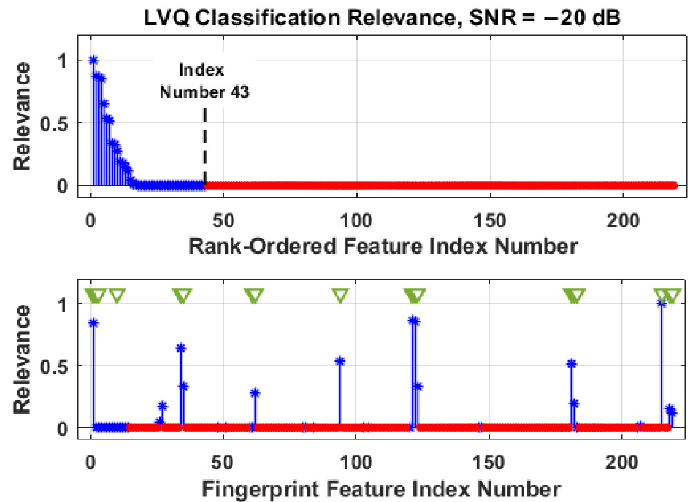
Figure 8. Stem plots illustrating DRA feature selection for LVQ classification using the N FD = 219 full-dimensional feature set. The blue asterisk ( ∗ ) markers denote the most relevant N DRA,LVQ = 43 features, the red dot ( • ) markers denote the least relevant 176-of-219 features, and the green triangle ( ▽ ) markers identify selected features shared in common with RndF in Figure 7.